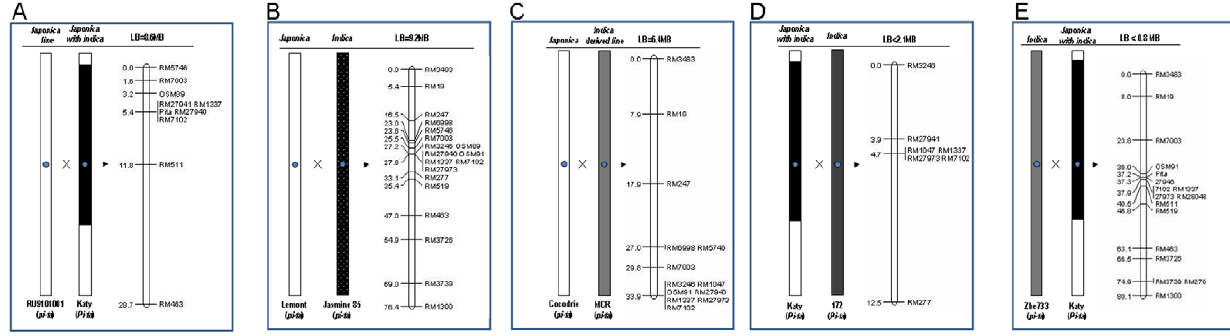
Figure 1. Genetic maps showing the size of linkage block among different crosses. A: Lemont and Jasmine 85; B: Early and Katy; C. Cocodrie and MCR 01-0277; D. Katy and Amane (172); E: Zhe733 and Katy. Graphic presentation of chromosome 12 with centromere, and difference of genotypes were indicated by different color shading (Left). Genetic distance in CentiMorgan defined by SSR marker and physical size of the linkage block defined by the two closest SSR markers was shown as LB=(Right) were shown.